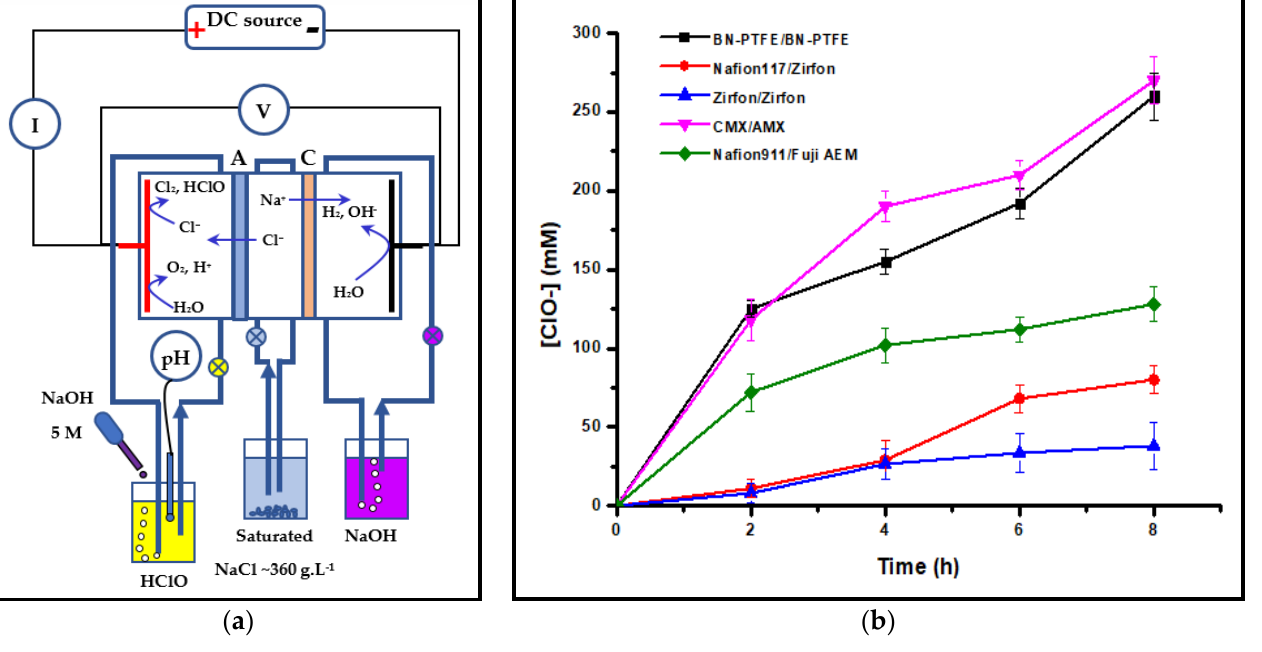
Figure 6. ( a , b ) Experimental device with its measurement instruments and solution circulations, and pH control system of the HClO compartment (( a )—left). Kinetic curves of hypochlorite ion generation by electrolysis of brine using various types of membranes (at constant rate, room temperature, J = 16.6 mA.cm − 2 , 4.5 < pH Anodic < 5.5) (( b )—right).